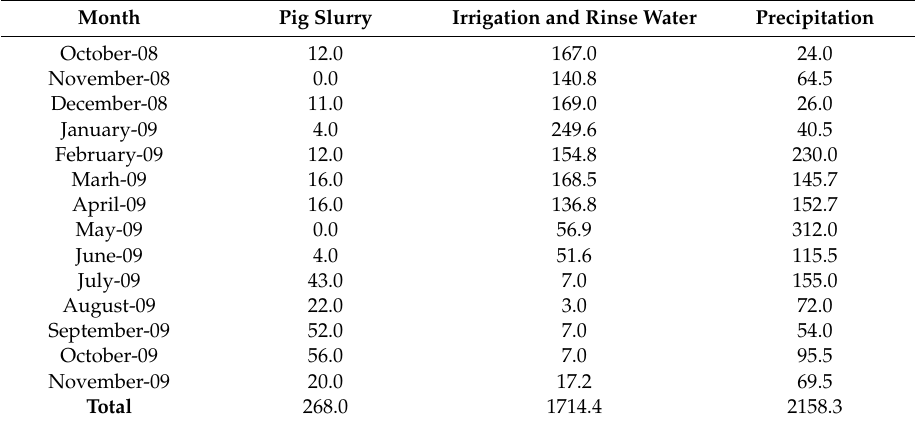
Table 7. Volume of pig slurry, irrigation water and precipitation by month (mm).